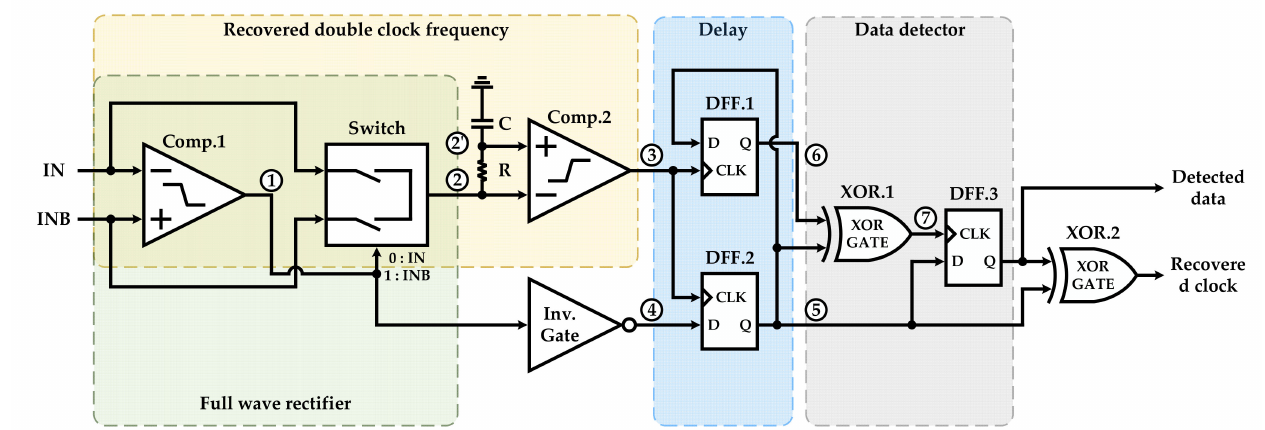
Figure 4. Structure of the proposed DBPSK